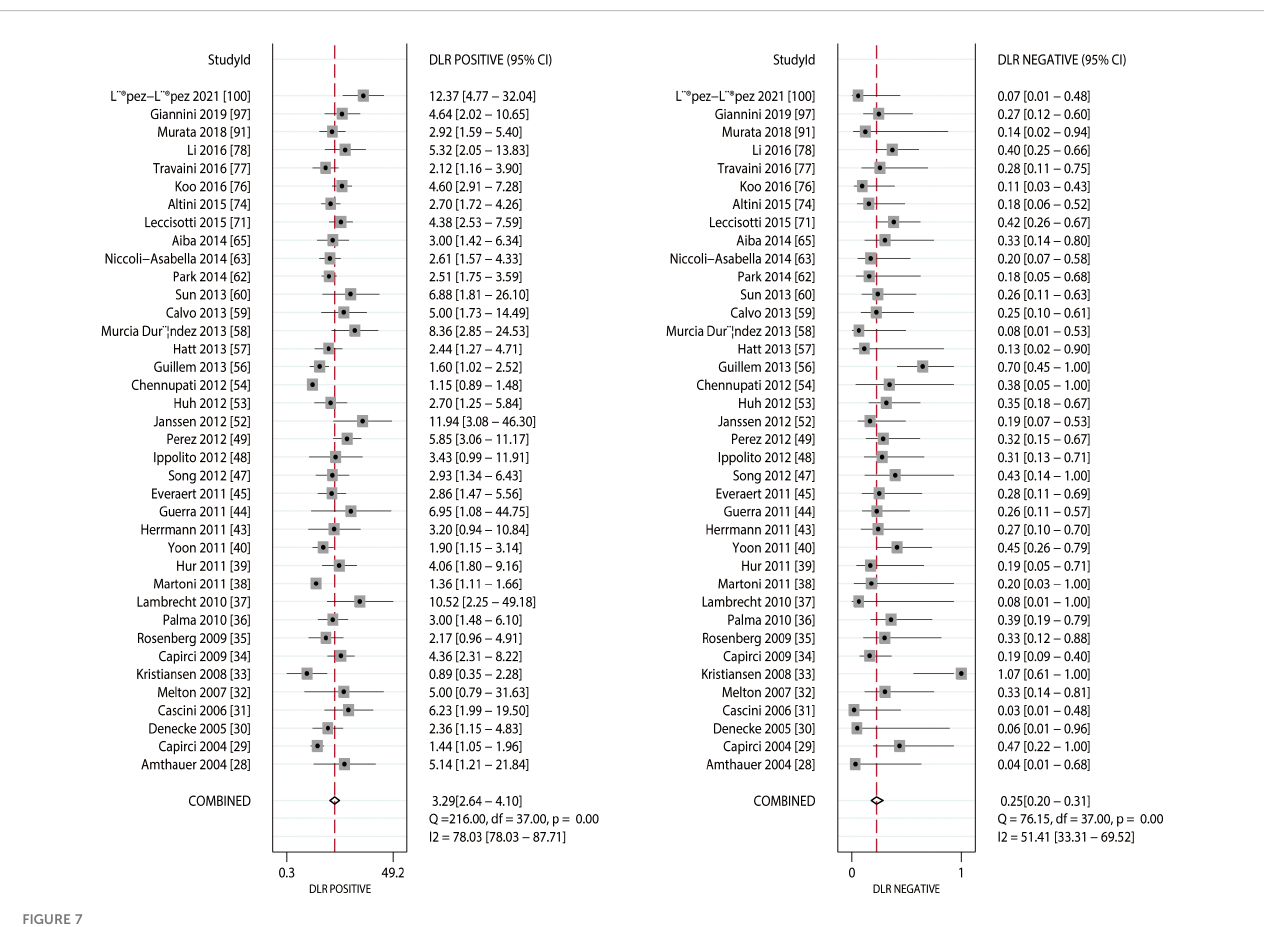
suggested no signi fi cant differences between MRI and FDG-PET or FDG-PET/CT for the response to neoadjuvant chemoradiotherapy in patients with locally advanced RC, in terms of sensitivity (ratio: 1.02;